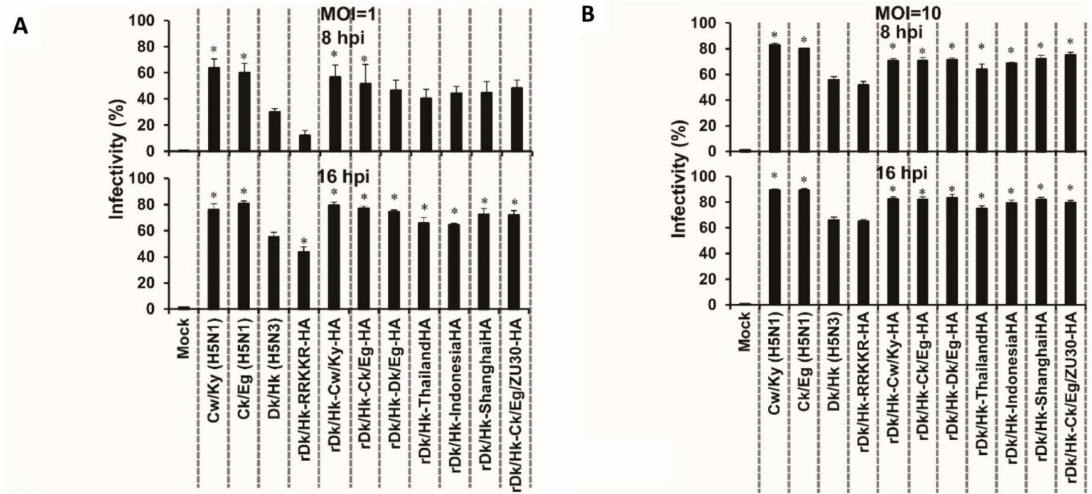
Figure 6. Susceptibility of primary human tracheal epithelial cells to infection by recombinant H5N3 viruses harboring the H5N1 HA gene. Human HTEpCs were infected (8 and 16 hpi at an m.o.i.